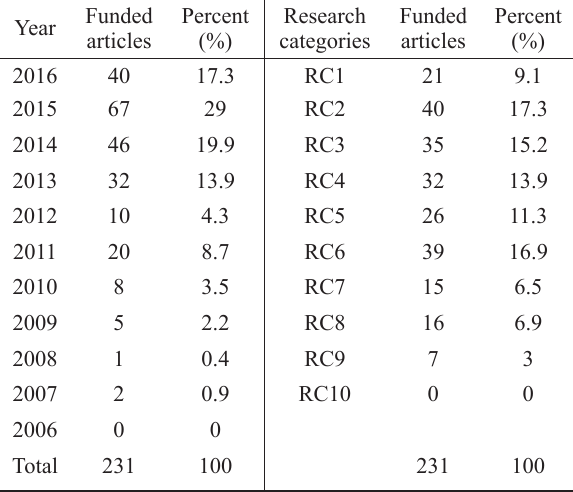
Table 7. Funding